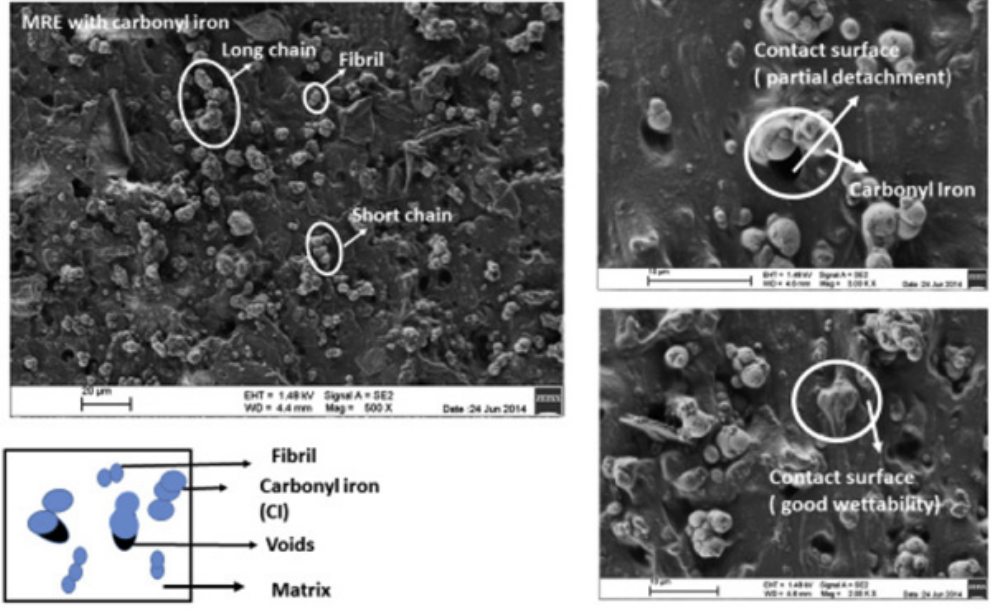
Figure 12. Isotropic filler distribution shows uniform movement within polymer composite, zoom view shows particle adhesion with voids towards the gravitational depth.